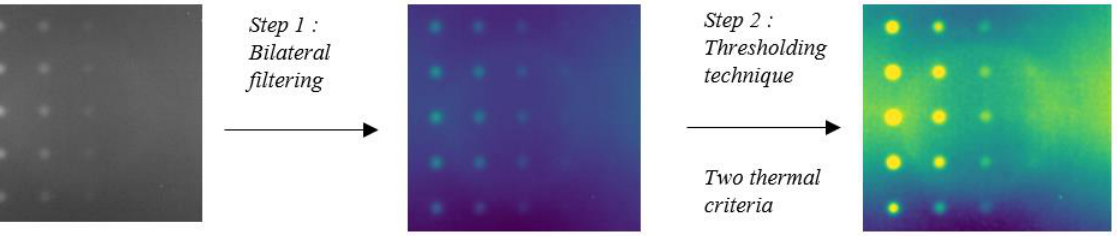
Big Data Cogn. Comput. 2021 , 5 , x FOR PEER REVIEW Figure 5. Proposed workflow to train with a deep learning model based on the data generation by Finite Element Modeling.